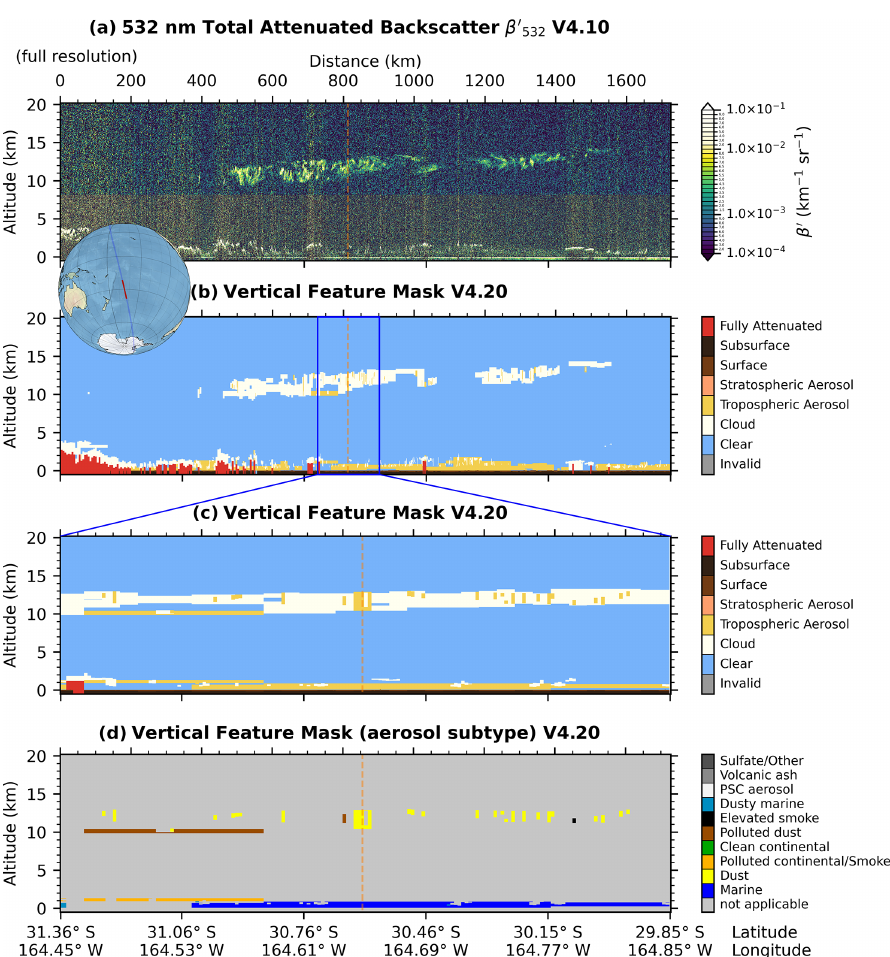
Figure 18. Misclassified dust monolayer by V4 CAD algorithm (CAD score , V4 = − 36) identified as cloud by IIR observation (CAD score , IIR = 99). The misclassified aerosol layer is located between 10.5 and 12.9km altitude in the 5km atmospheric column (5km index no. 1541) indicated by a dashed line. CALIOP daytime observations on 1 March 2018, 01:01:13–01:05:25UTC, over the South Pa- cific: (a) 532nm total attenuated backscatter V4.10, (b) vertical feature mask V4.20, (c) vertical feature mask zoom around the atmospheric column of interest, and (d) aerosol subtyping. The marine aerosol layer in the planetary boundary layer is detected with 80km horizontal averaging and does not affect the IIR